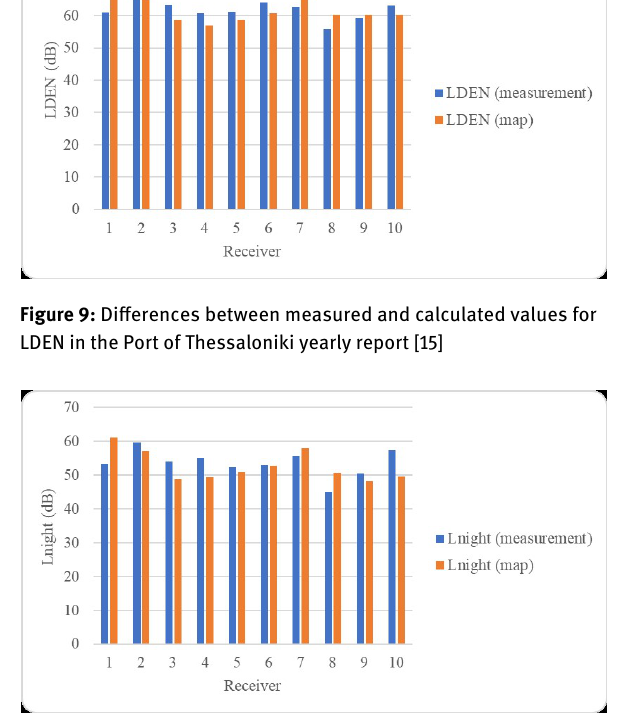
Figure 10: Differences between measured and calculated values